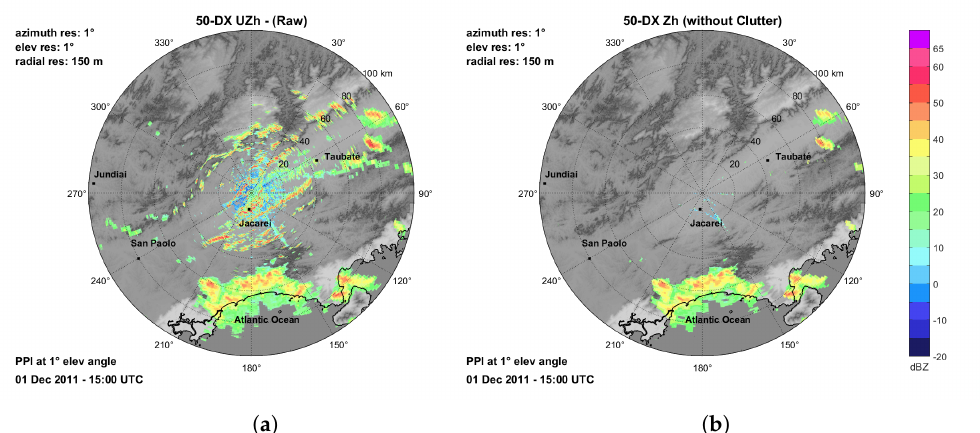
Figure 4. PPI, at lowest elevation angle of ( a ) raw reflectivity and ( b ) reflectivity filtered to remove the clutter contamination on 1 December 2011 in the Vale do Paraíba campaign.